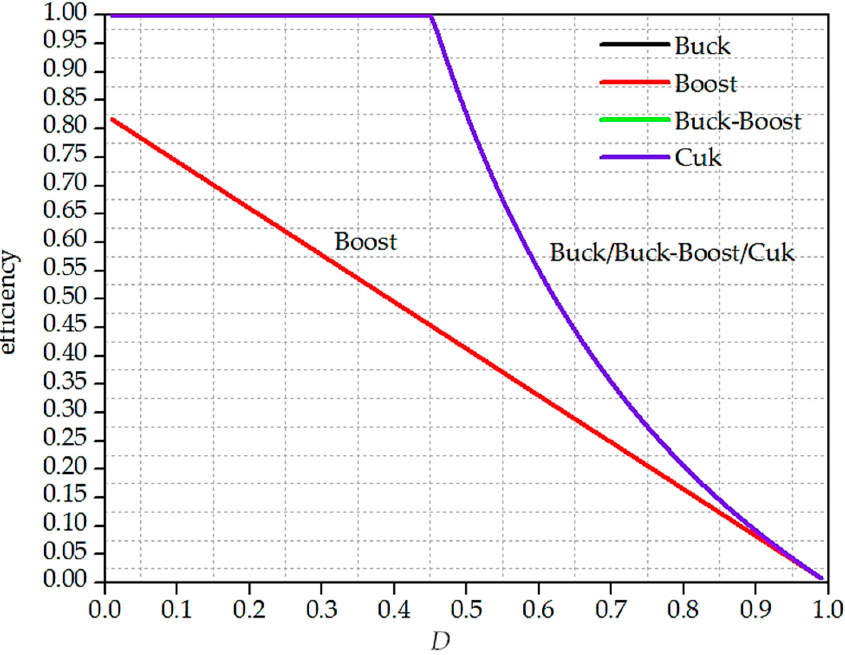
Figure 11. Relationship between efficiency and D of the LED in the diode converter.